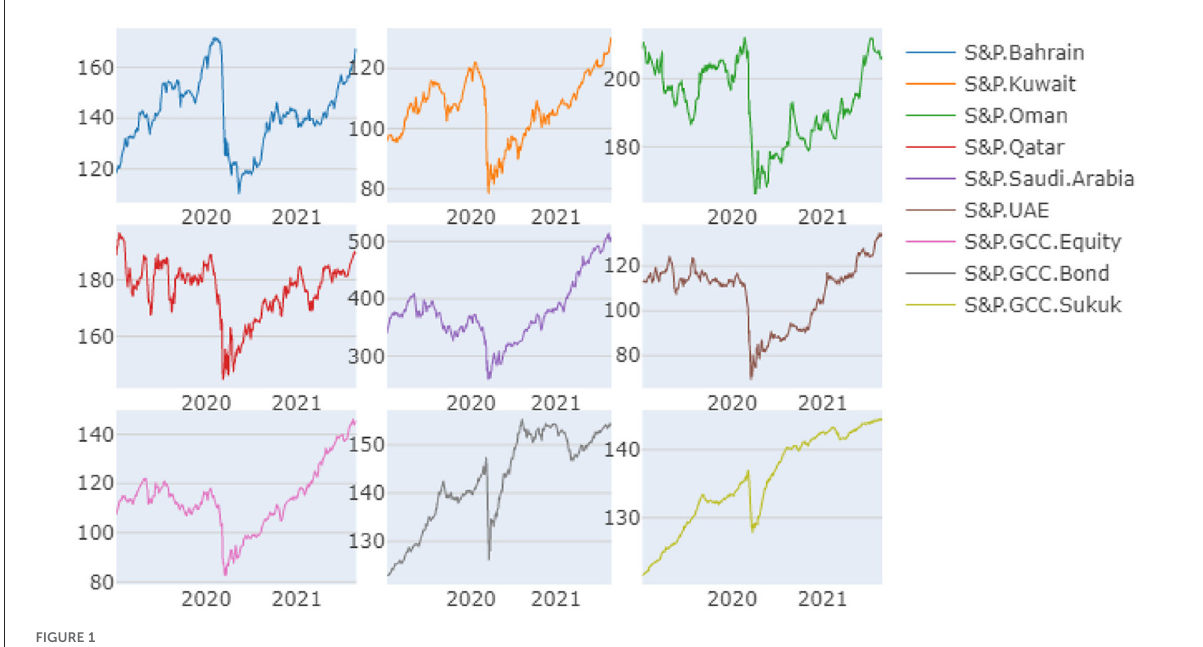
FIGURE1 The S&P equity, bond and Sukuk indices